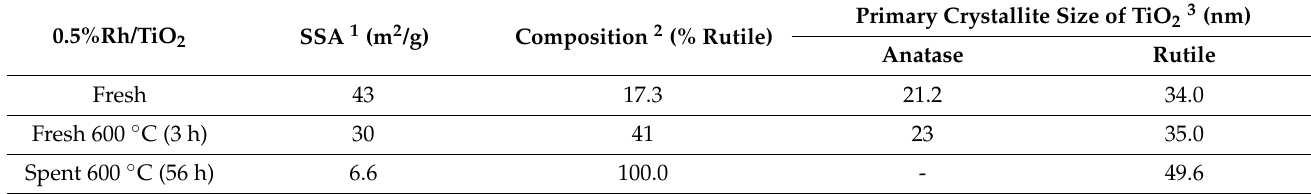
Table 1. Characteristics of fresh and spent 0.5%Rh/TiO 2